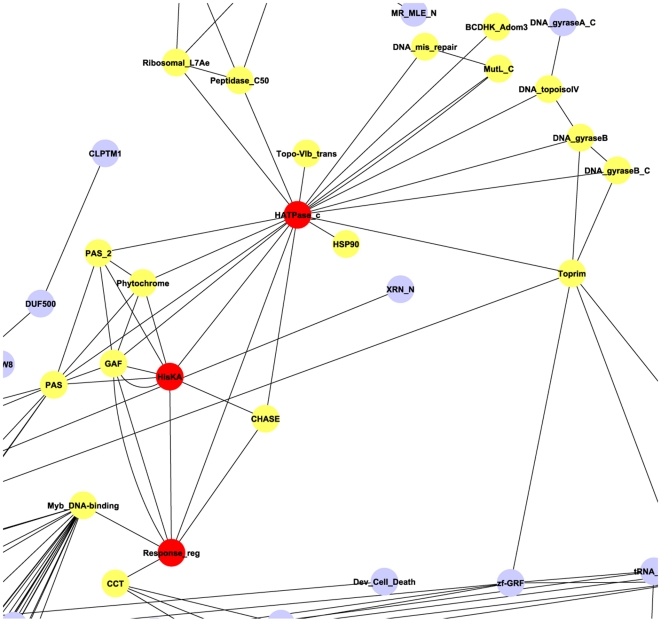
An example showing the DCN-based aggregated neighbor-counting method for protein function prediction.The query protein for this example contains 1,225 amino acids and has an ID “DDB_G0274191” in DictyBase (http://dictybase.org/gene/DDB_G0274191). Three unique Pfam domains (red vertices) were detected by HHsearch, each with an e-value< = 0.01. It had a PSI-BLAST hit to a protein of Vitis vinifera (grape) with an e-value e-118. Therefore, the DCN of Vitis vinifera was used to make predictions. The vertices in yellow are the radius one neighboring vertices of the three Pfam domains. The GO terms of these yellow vertices were put together and ranked based on their occurrence frequencies. This query protein contains 14 real GO terms. Everyone of the top 3 predictions (GO:0005524, GO:0006355, and GO:0016020) ranked by DCN-based aggregated neighbor-counting method matches one of the real GO terms. Besides that, the 5th (GO:0007165), 7th (GO:0000155), 13th (GO:0000160), and 14th (GO:0000156) ranked GO terms have an exact match to the real GO terms.